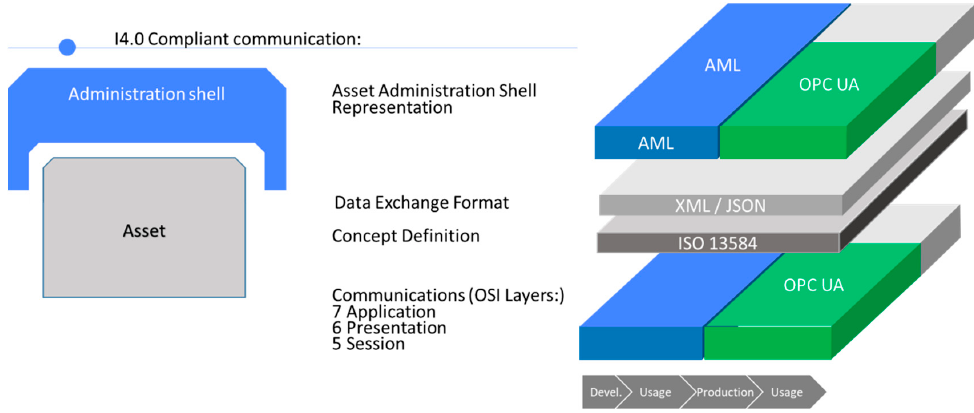
Figure 2. I4.0 Communication protocol stack.